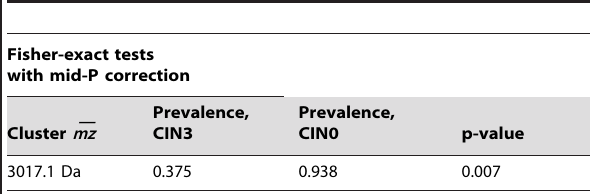
Table 3. CIN0 vs. CIN3 prevalence differences scored using the Fisher-exact test with mid-P correction.